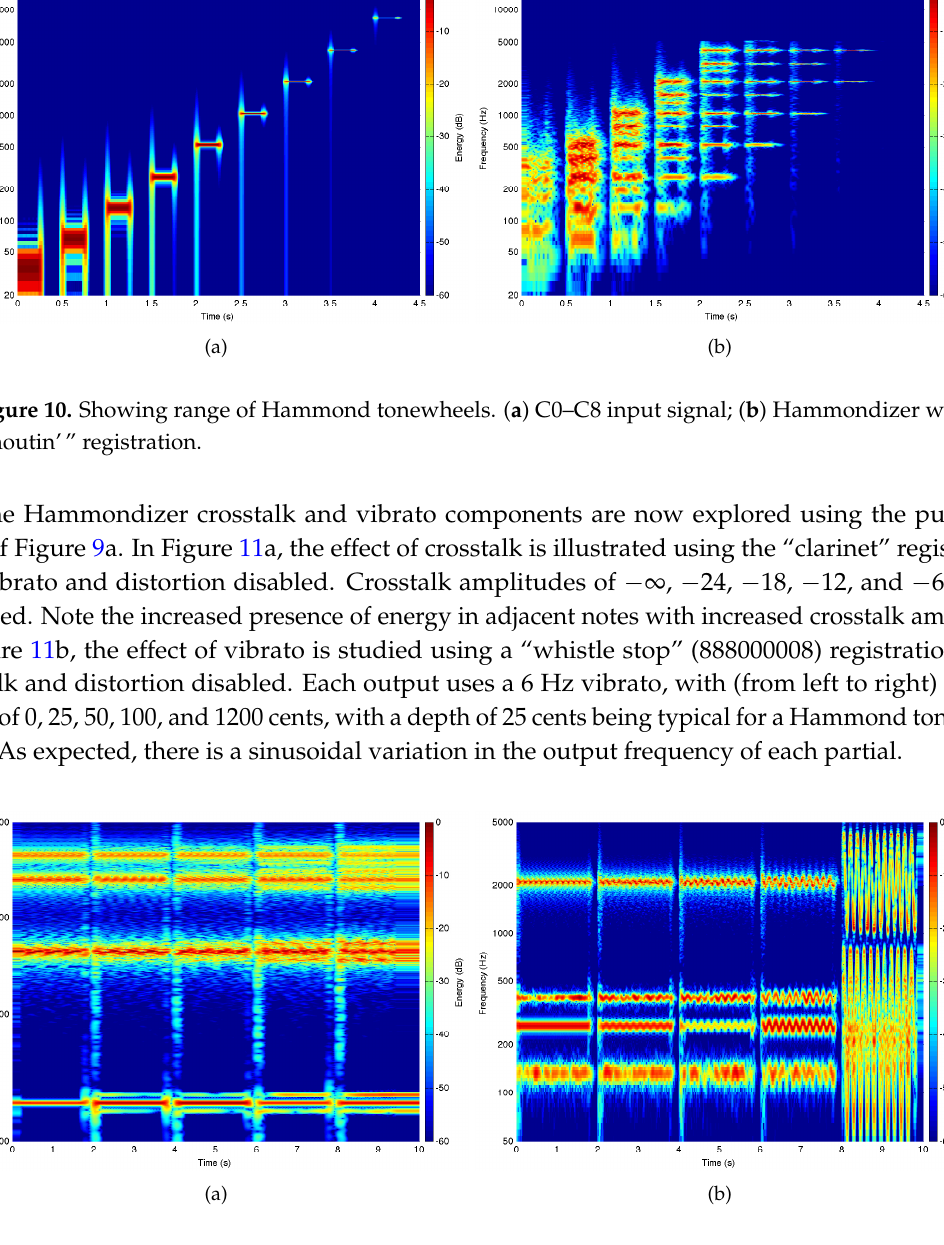
Figure 11. ( a ) Clarinet registration, various levels of crosstalk ∈ [ − ∞ , − 24, − 18, − 12, − 6 ] dB and ( b ) Whistle stop registration, various levels of vibrato ∈ [ 0,26,50,100,1200 ] cents on the